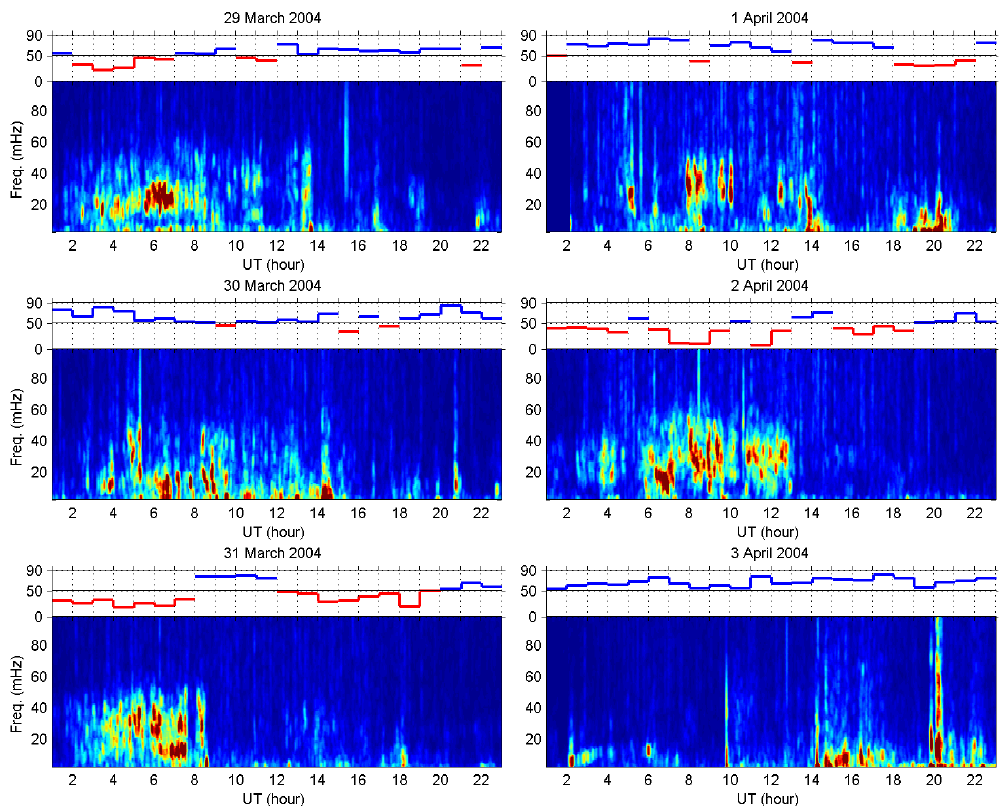
Fig. 2. Dynamic amplitude spectra of the D -comp. at NCK. Data have been time differenced before spectral processing to better visualize Pc3 (20mHz–100mHz) wave activity. The amplitude scale is different for each day. Hourly values of the cone angle (taking into account the propagation delay from ACE spacecraft to the magnetopause) are shown at the top of each spectrum. Favourable (unfavourable) conditions for upstream wave transmission in the magnetosphere are evidenced by the different colour: red (blue) for θ XB lower (higher) than 50 ◦